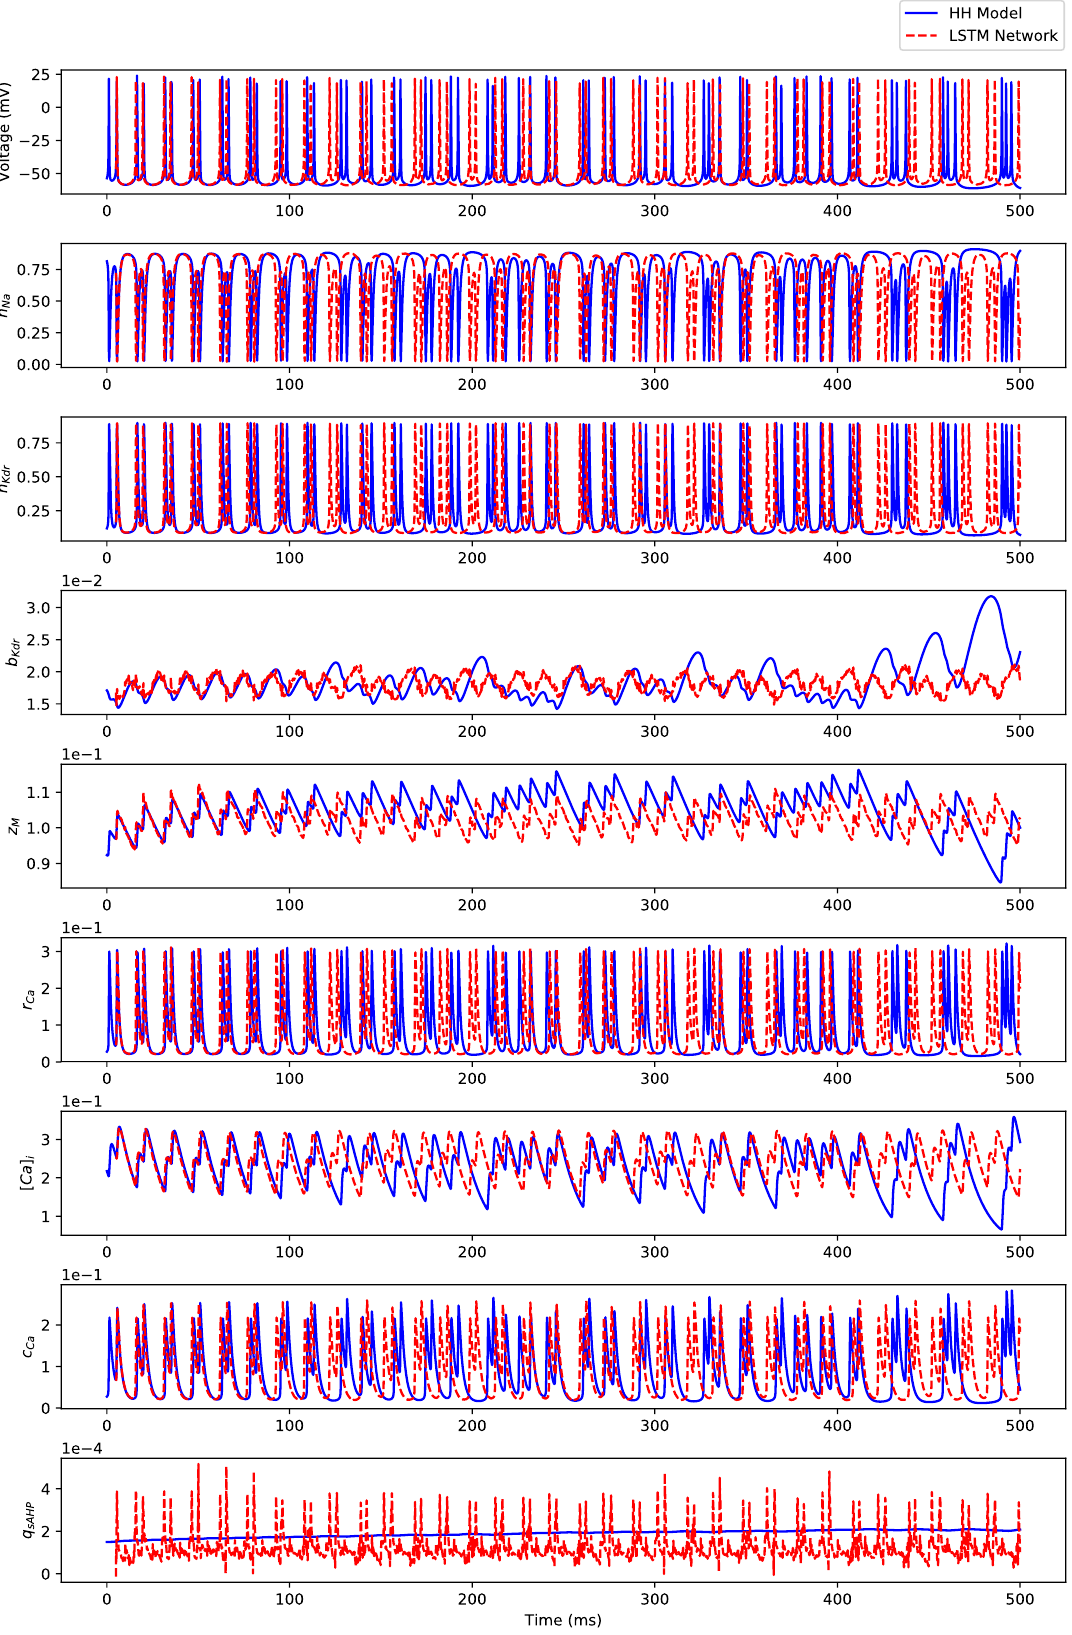
Figure A7. Comparison between the Hodgkin-Huxley model (“HH Model”) states’ dynamics and the iterative predictions of states’ dynamics using the 50 timesteps predictive horizon-based deep LSTM neural network (“LSTM Network”) in response to I = 1.5